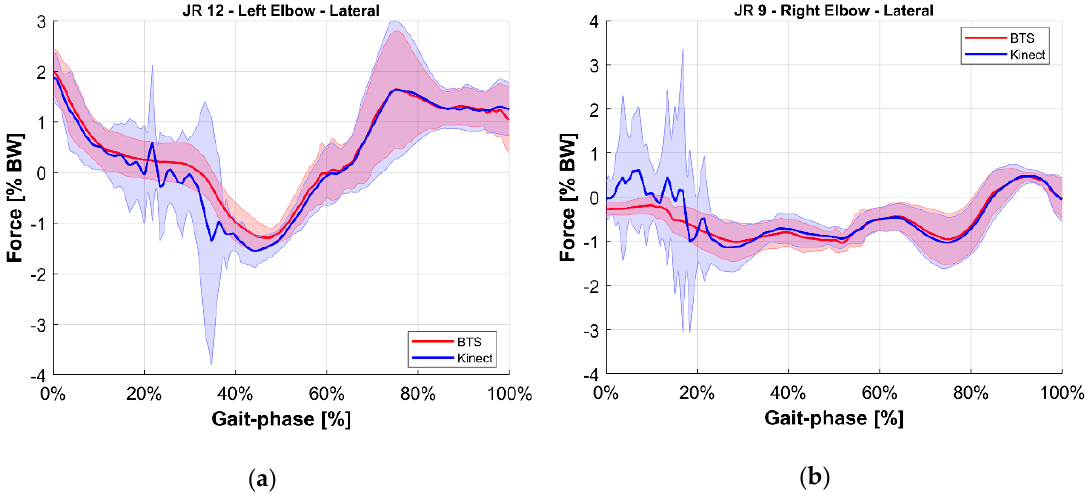
Figure 14. Vertical internal reaction force at the elbow joint. Blue indicates the M-Kinect assessment. Red indicates the reference using BTS marker-based mocap. Bold lines represent the average of all tests. The shaded areas represent their standard deviation. ( a ) Left joint. ( b ) Right joint. The subject was right-dominant.